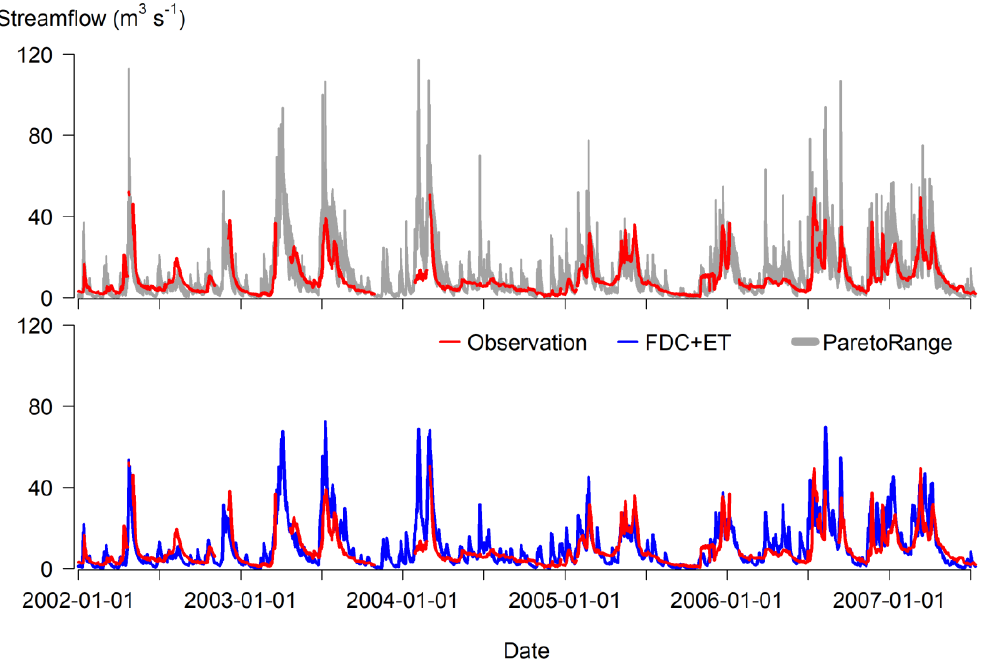
Figure 11. Daily simulated and observed streamflow comparisons for the Nyangores River at Bomet. Top panel: the range based on the 13 selected Pareto set solutions (ParetoRange); bottom panel: simulated streamflow based on manual calibration using evapotranspiration and signature measures.